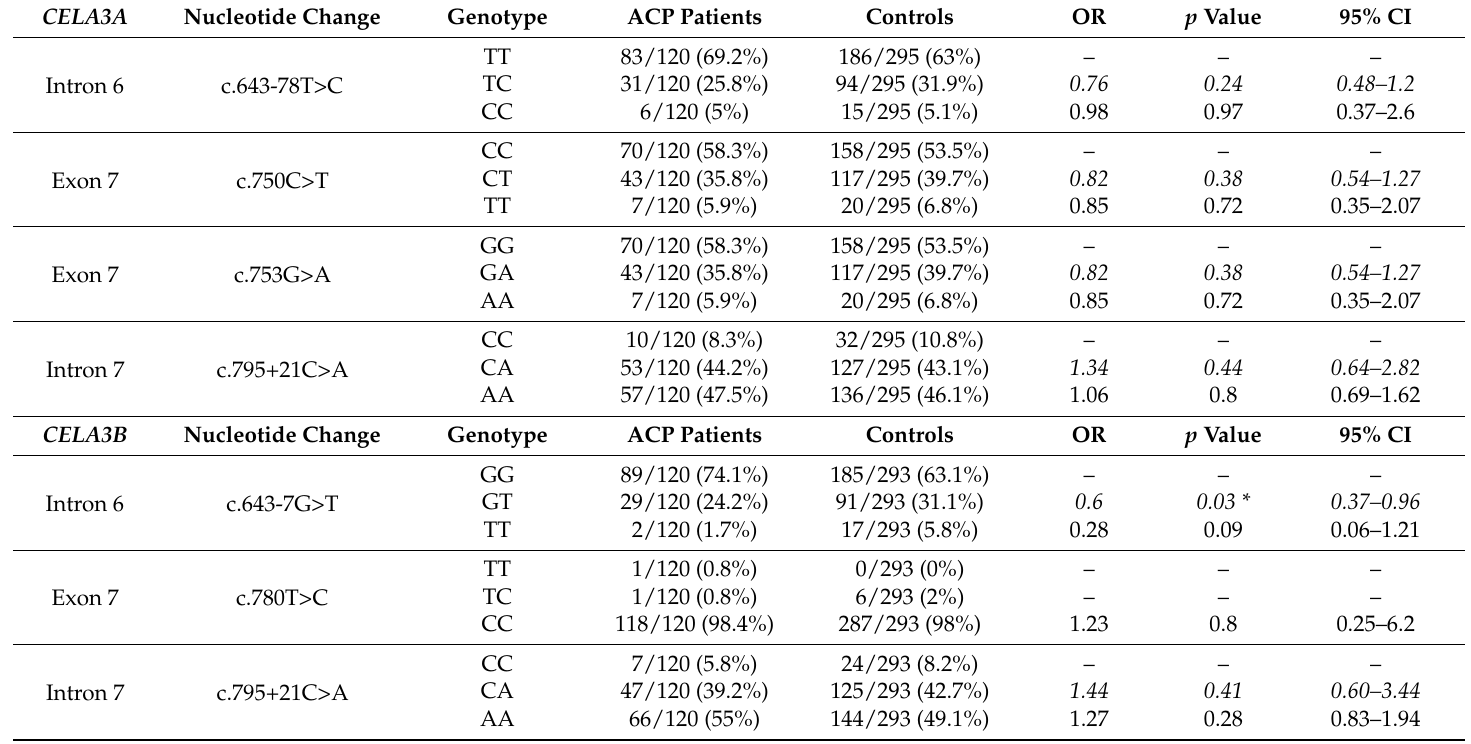
Table 5. Genotype distribution of common CELA3A and CELA3B variants in patients with alcoholic chronic pancreatitis (ACP) and controls without pancreatic disease. Results were analyzed assuming dominant (shown in italics) or recessive models of inheritance. OR, odds ratio; CI, confidence interval. Asterisk indicates significant